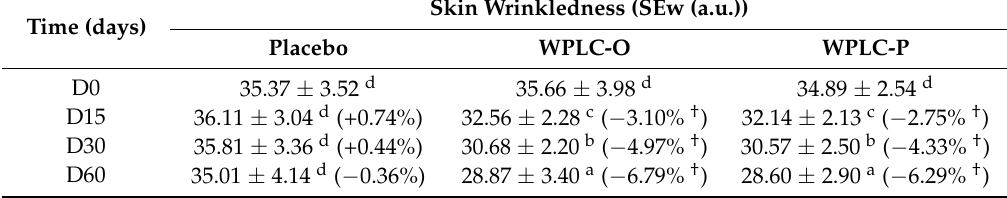
Table 9. Skin wrinkledness variation results after 15, 30 and 60 days of supplementation with WPLC-O and WPLC-P. Data are mean ± SD in SEw (a.u.).